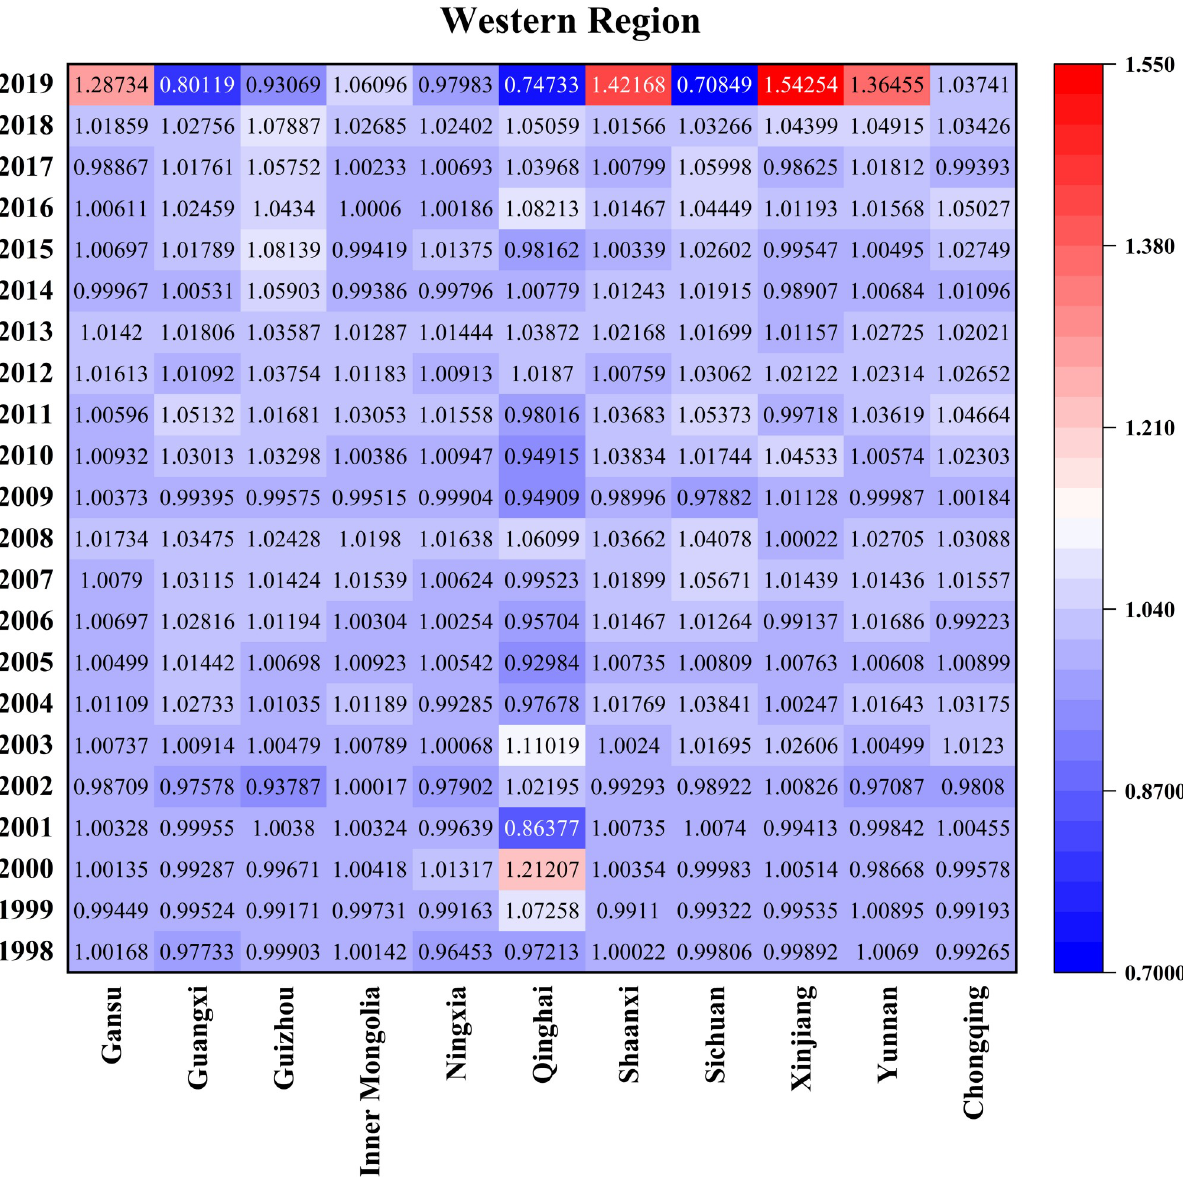
Fig 9. Time variation and average TGRs of GATFP in the western